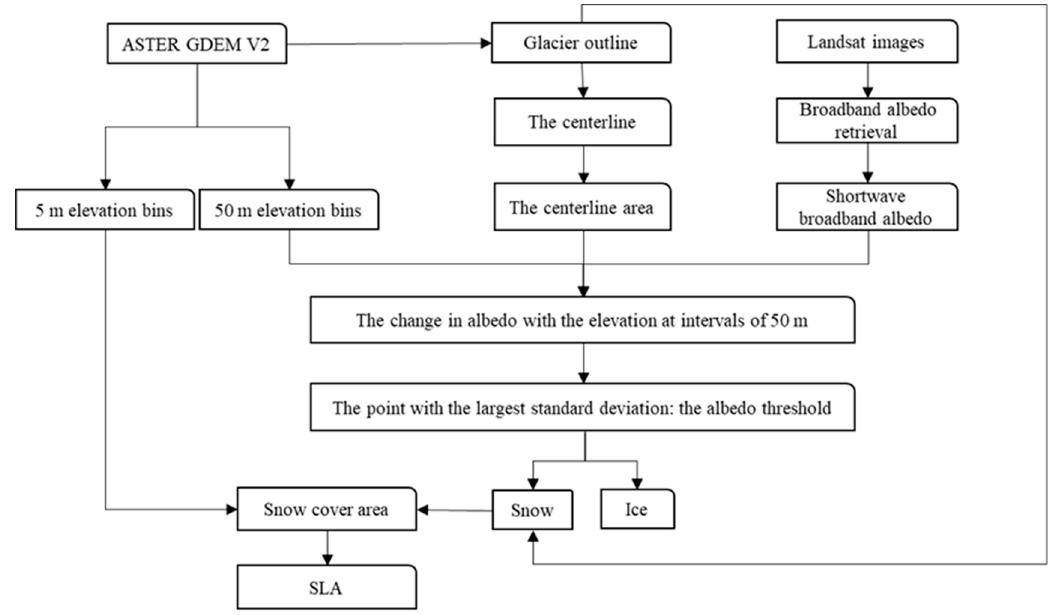
Figure 2. Flow chart of the methodology applied to select the threshold discriminating snow and ice based on the derived shortwave broadband albedo. For a further explanation, please see the text.